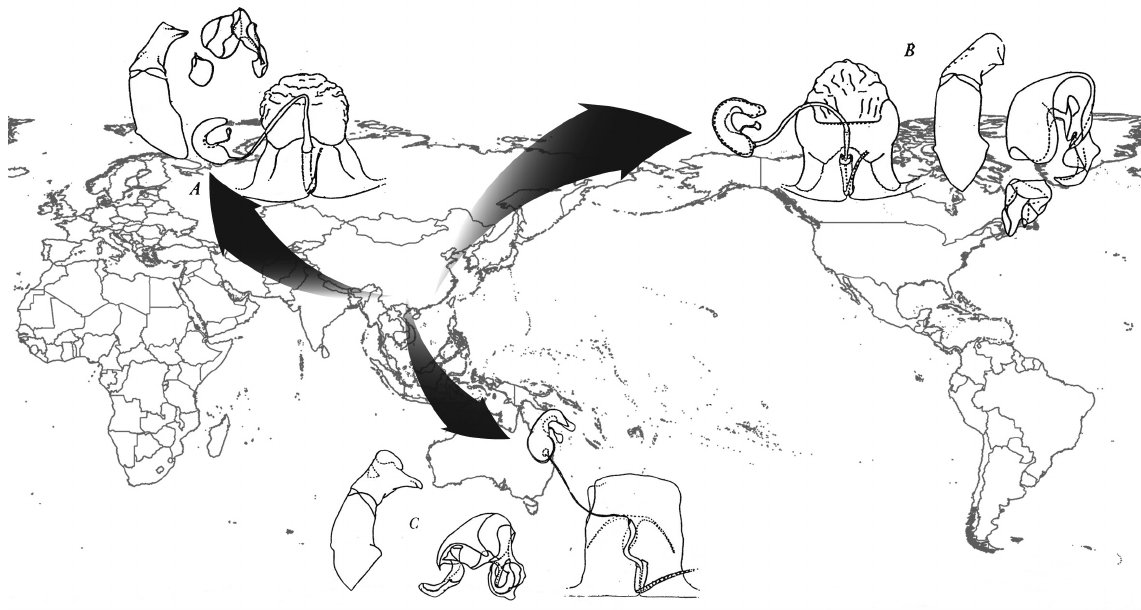
Fig. 5. Hypothetical dispersion/dispersal of Onthophagus s.str. Latreille, 1802, modified after Palestrini (1985). The map is based on the current geography of the